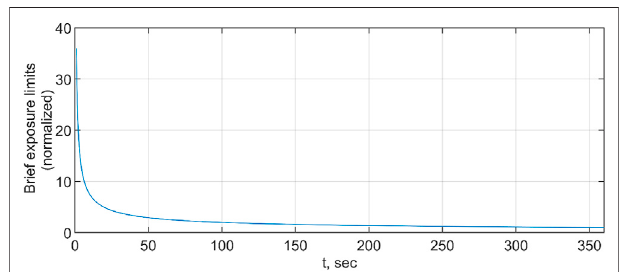
FIGURE 9 | Limit for “ brief exposure ” (t < 6 min), see Supplementary TableA3 ,dividedbythecorrespondingtimeinterval t andnormalizedwiththe valueobtainedfor t approaching6 min.Forvisualizationpurposes,thecurveis plotted for t > 1 s. For shorter t, the limits for brief exposure increase (the corresponding normalized value for t = 1 ms is about